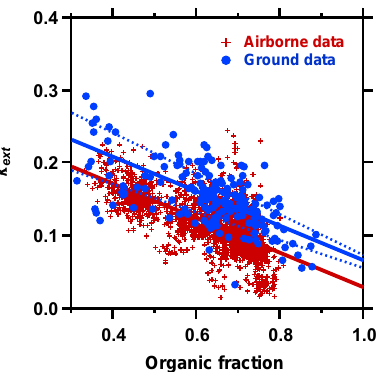
Figure 8. Comparison of κ ext as a function of the fraction of sub-0.7µm non-refractory OA for the data analyzed in this paper (crosses) and similar measurements at the SOAS ground site in Centreville, Alabama, US (Washenfelder et al., 2015), between the hours of 11:00 and 17:00local time